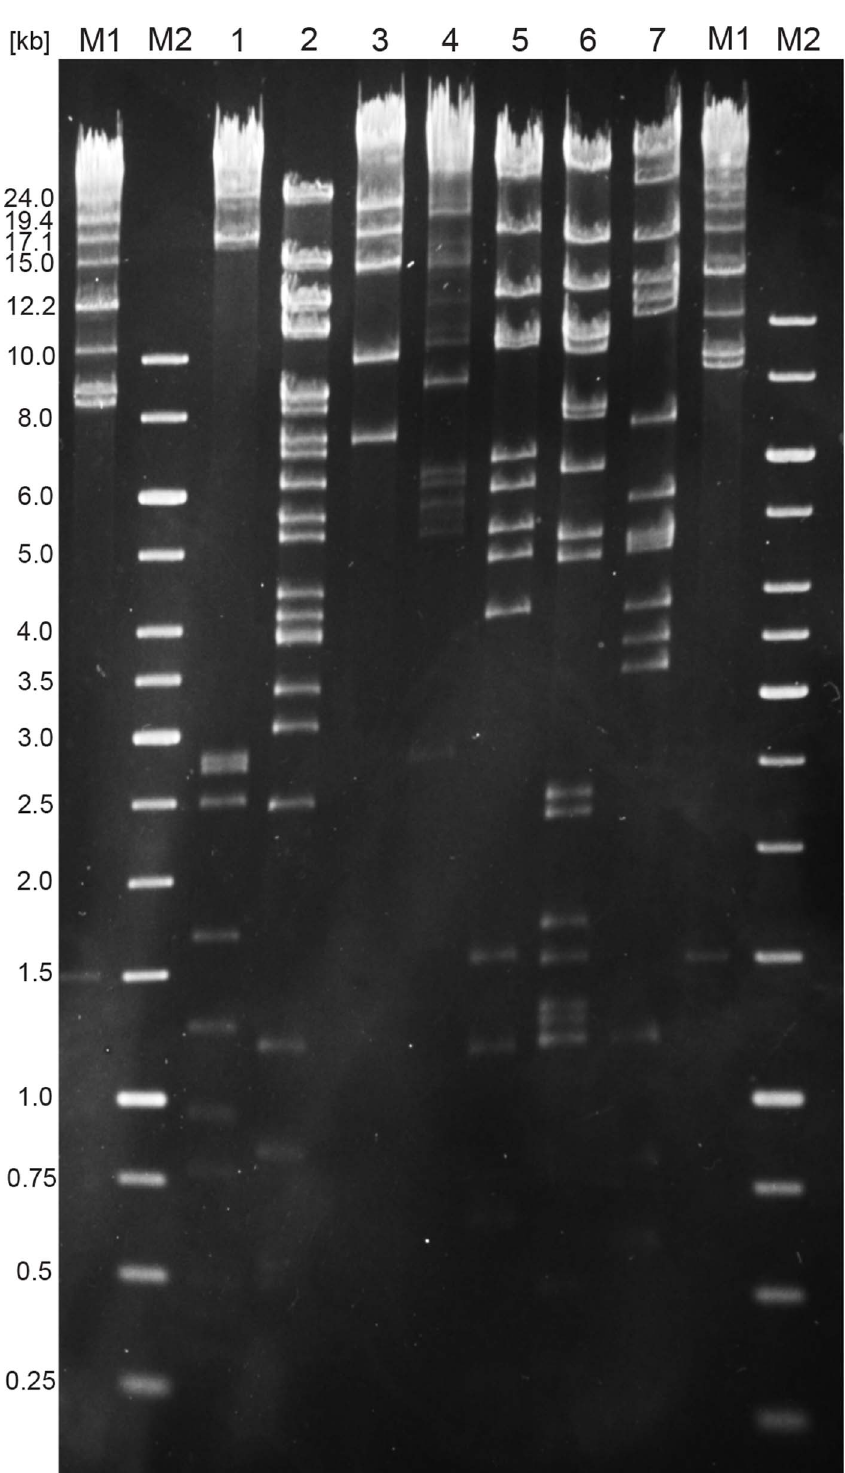
Figure 3. Restriction profile of Tsamsa phage. 500 ng DNA were digested with different restriction enzymes for 2 h at 37 u C and electrophoresed. Clear band separation up to 24 kb in size was achieved and the restriction profiles matched with the sequenced genome size. The terminal redundancy location and size was determined from the fragment sizes as previously described [13,15]. Enzymes used: 1: Alw44I (NEB); 2: Eco91I (Fermentas); 3: NheI (NEB); 4: PacI (NEB); 5: SwaI (NEB); 6: Van91I (Fermentas); 7: XcmI (NEB). M1: Lambda 19 Mix Size standard (Fermentas); M2: 1 kb size standard (Fermentas). Numbers to the left indicate band size in kb.